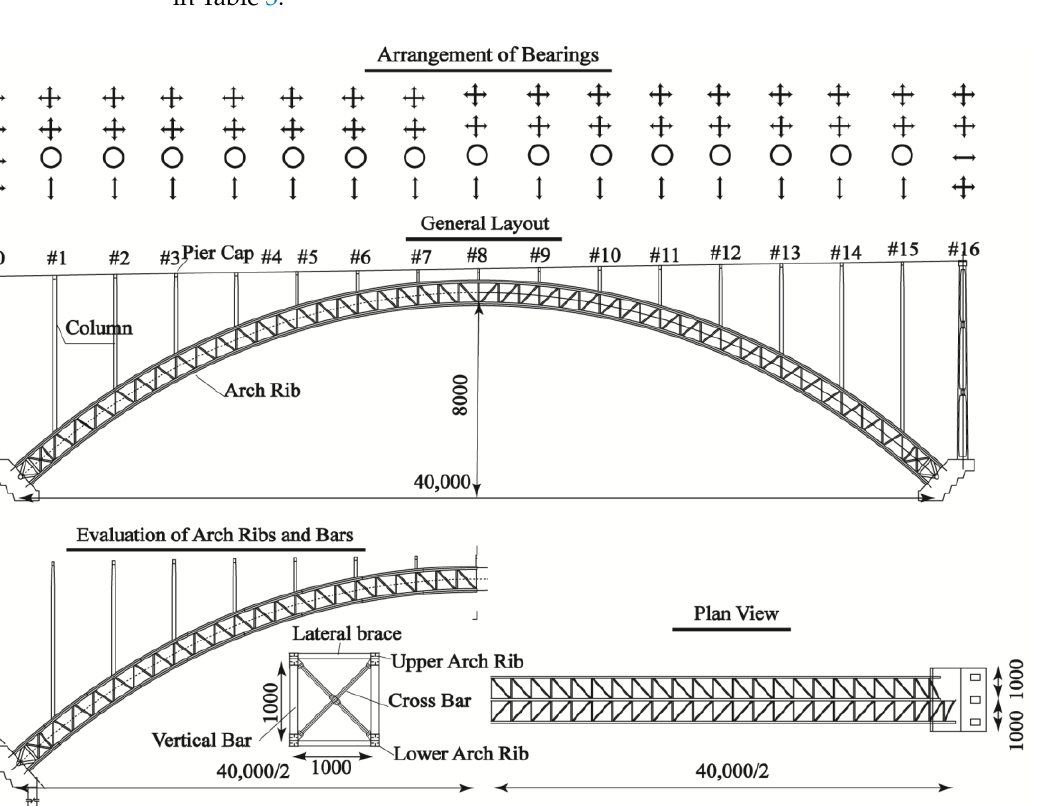
Figure 3. General layout of bridge. (unit:cm). Table 2. Section of members.